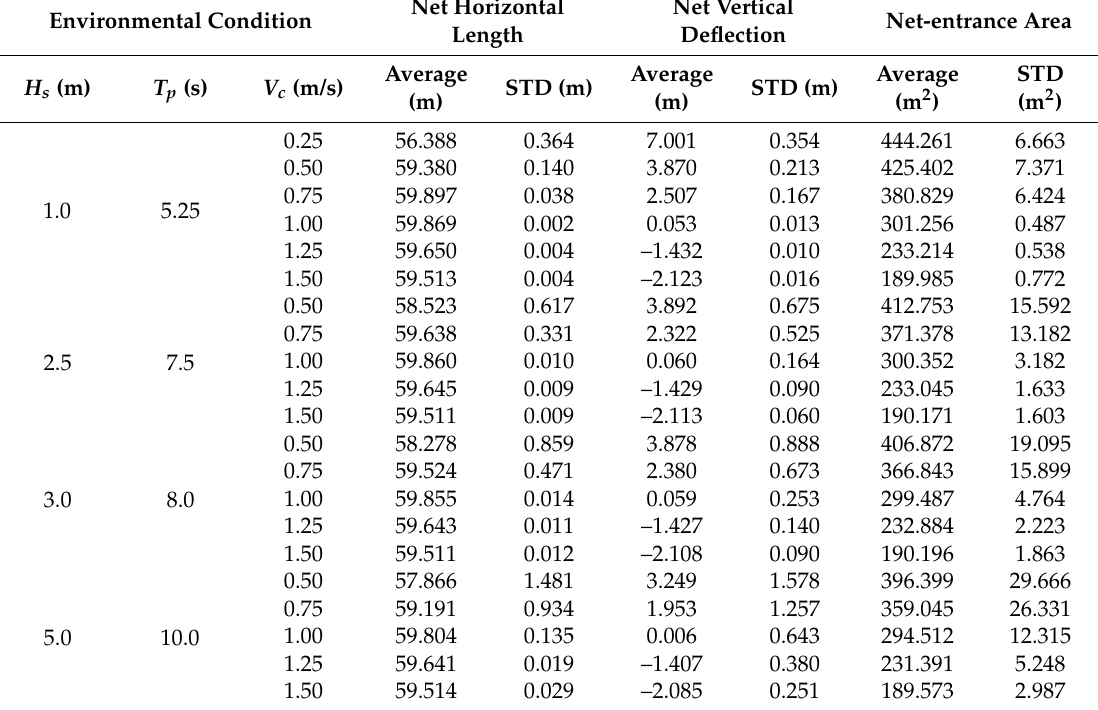
Table 3. Statistical data of net horizontal length, net vertical deflection and net-entrance area for all simulated